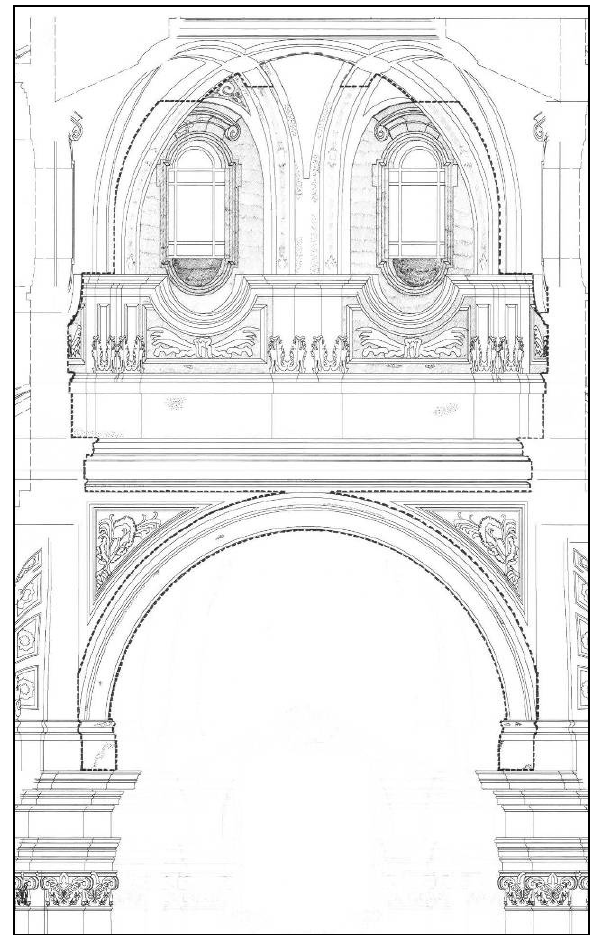
Figure 8 - Mapping of degradation on a survey drawing